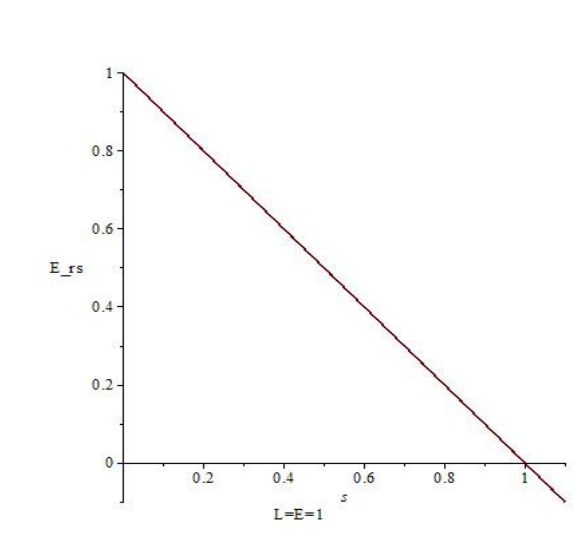
FIG. 1. ENERGY VERSUS TIME